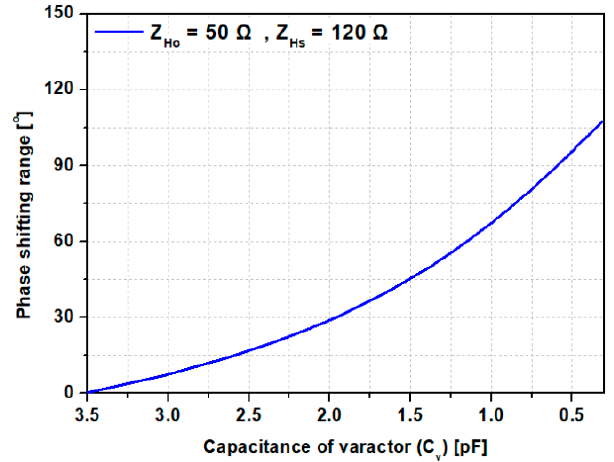
Figure 4. PSR with C v variations at f L ( C v = 3.5 to 0.3 pF @ f L ).